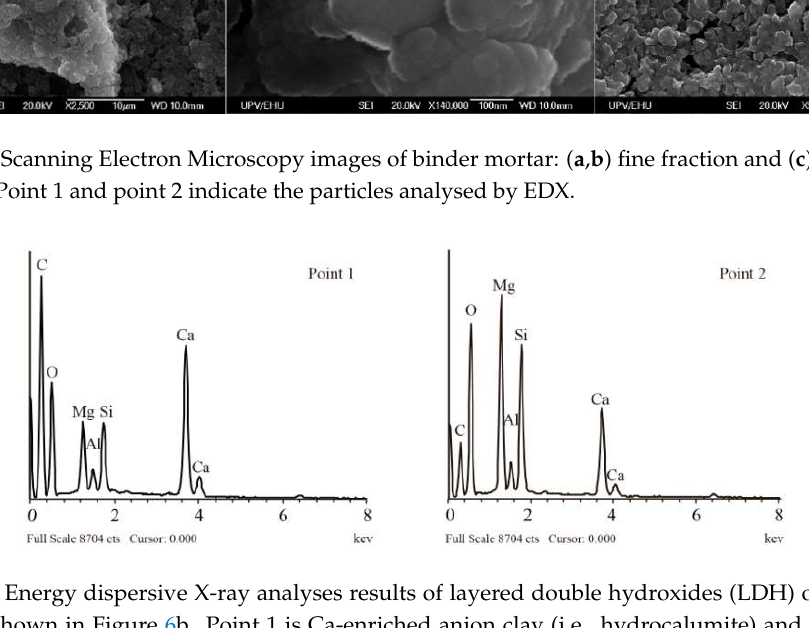
Figure 7. Energy dispersive X-ray analyses results of layered double hydroxides (LDH) of the fine fraction shown in Figure 6b. Point 1 is Ca-enriched anion clay (i.e., hydrocalumite) and point 2 is Ca-enriched anion clay (i.e., hydrotalcite).